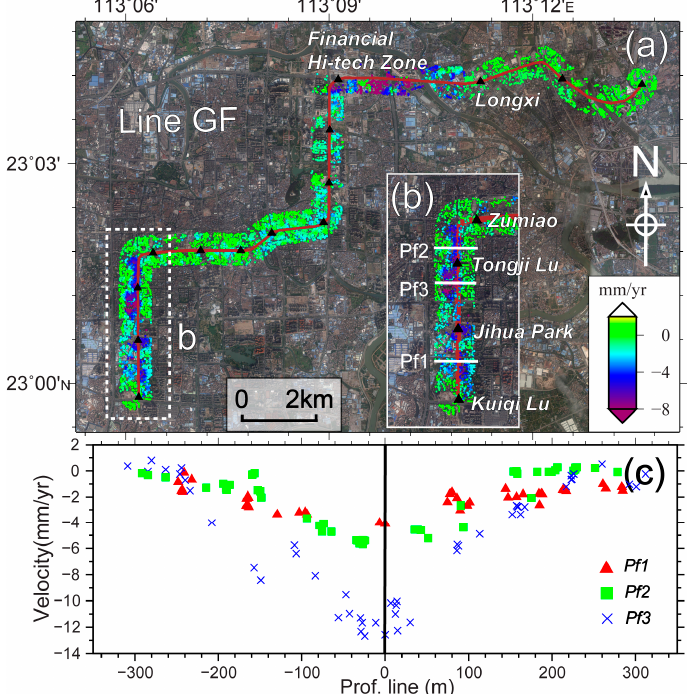
Figure 8. Deformation rate map of Line Guangfo obtained by PALSAR and the subsidence patterns of metro section profiles in soft soil area. ( a ) The deformation map of Line GF; ( b ) Metro section from the Kuiqi Lu station to the Zumiao station; ( c ) Profiles of Pf1, Pf2, and Pf3.